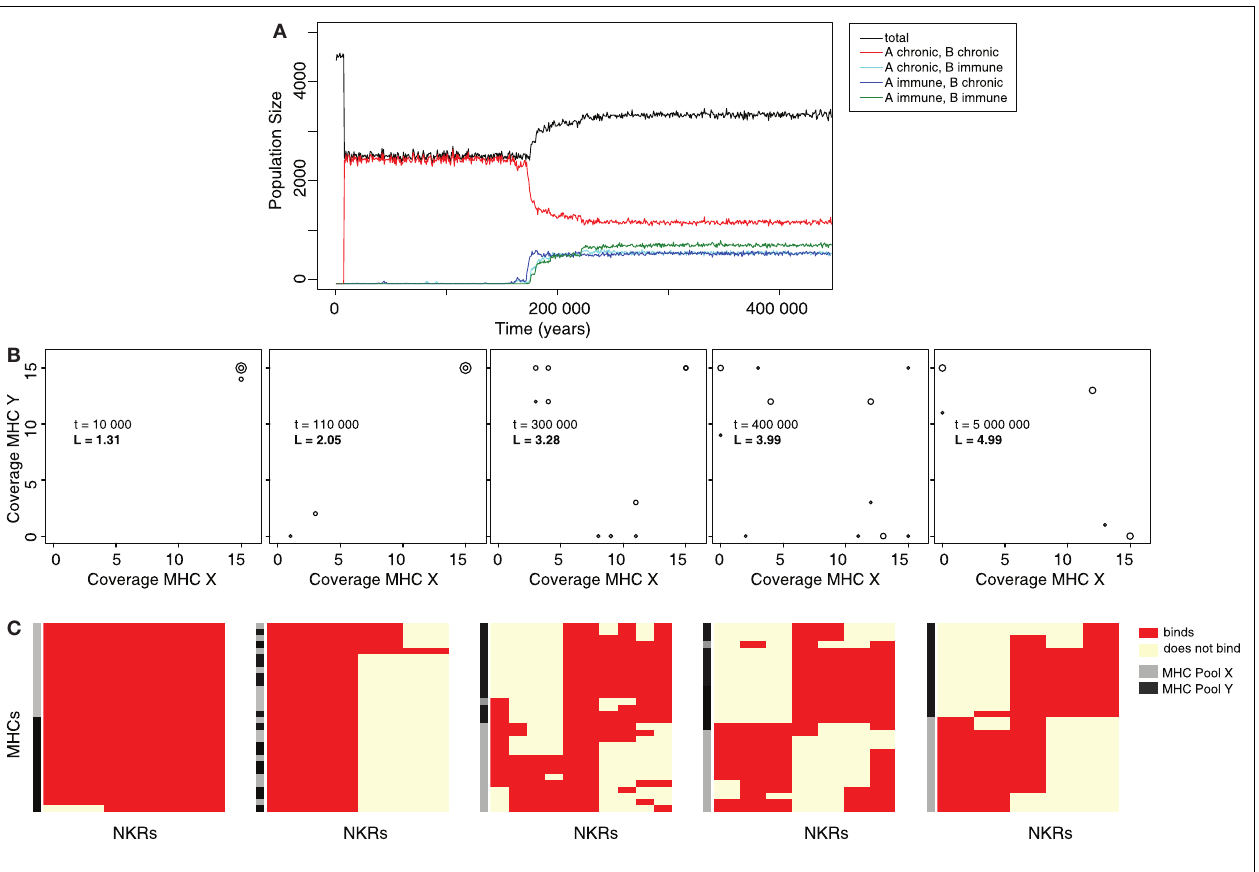
FIGURE 2 | The evolution of MHC-X and MHC-Y detectors provides immunity . (A) Representative simulation of a host population infected with both viral species. After their introduction at t 1 = 10000, the viruses spread rapidly through the population, infecting most individuals, and causing a drastic decrease of the total population size (black line). Most hosts are chronically infected with both viruses simultaneously (red line). After several host generations, some hosts evolve immunity to viruses downregulating MHC-X molecules but remain chronically infected with viruses downregulating MHC-Y (blue line). Shortly afterwards, other individuals become immune to viruses downregulating MHC-Y molecules while being chronically infected with viruses downregulating MHC-X (cyan line). Finally, hosts that are able to clear both viruses evolve (green line), resulting in a